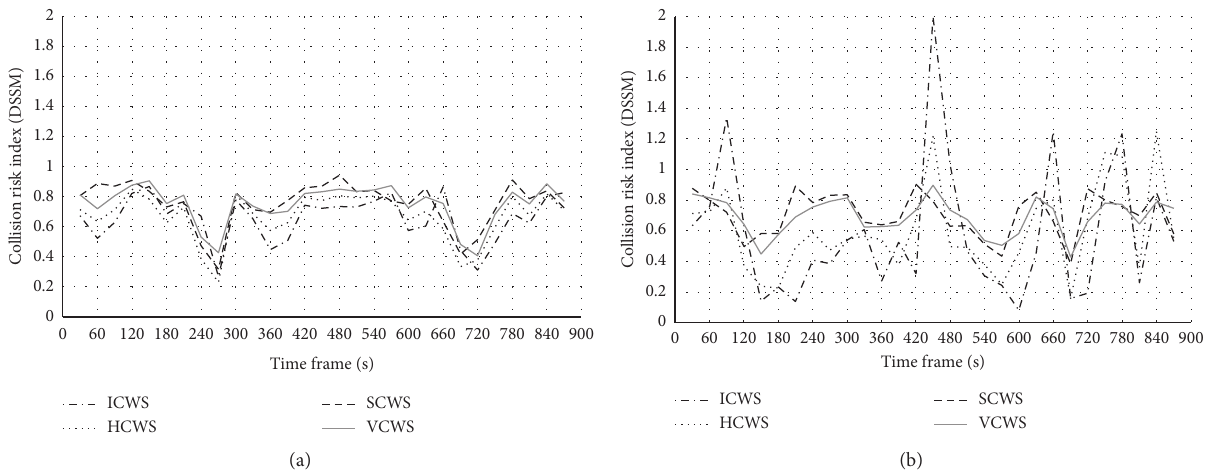
Figure 5: Aggregated level comparison of collision risk calculated using four different collision warning systems: (a) example 1; (b) example 2.